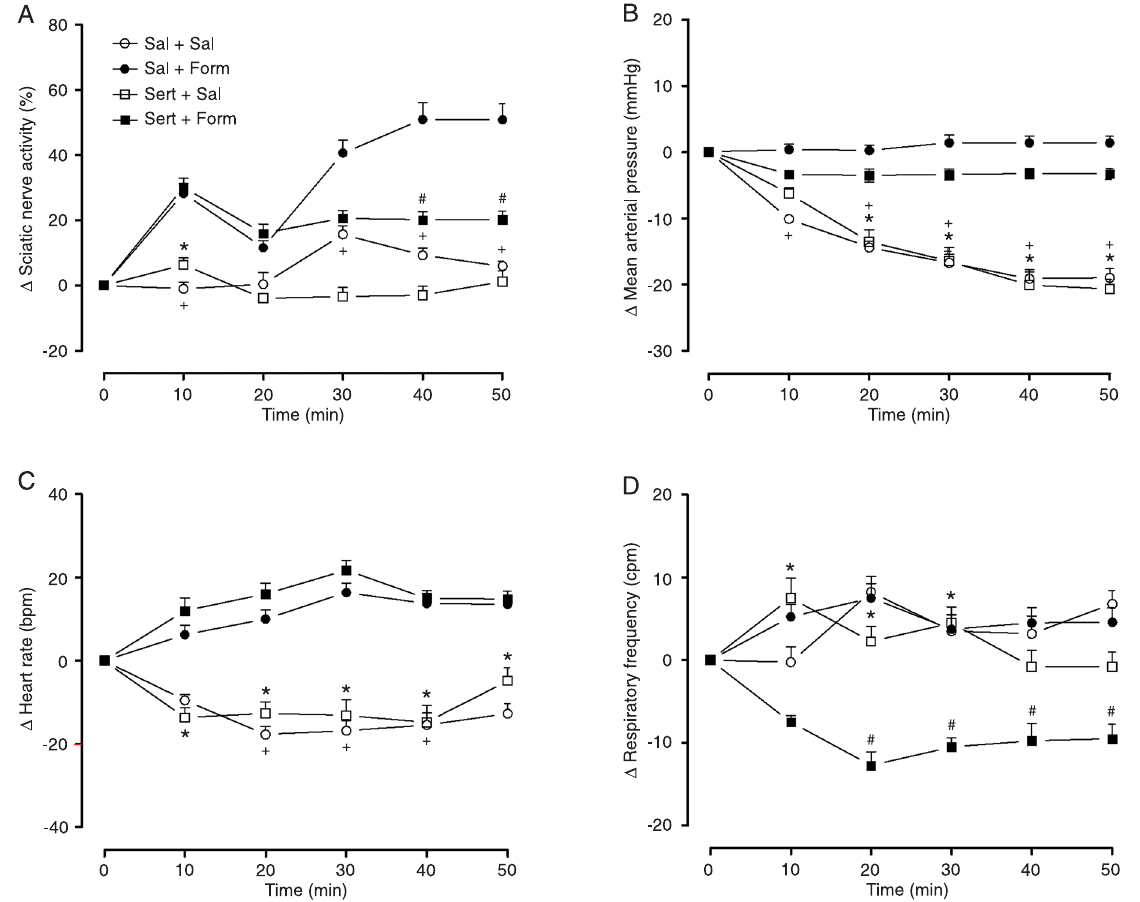
Figure 1. Effects of sertraline administration on A , sciatic nerve activity; B , mean arterial pressure; C , heart rate; D , respiratory fre- quency in an animal model of acute pain produced by the injection of 50 μL 5% formalin. Data are reported as means ± SEM for N = 8 rats per group. Sal = saline; Form = formalin; Ser = sertraline. *P < 0.05, Sert + Form vs Sert + Sal group; + P < 0.05, Sal + Form vs Sal + Sal; # P < 0.05, Sal + Form vs Sert + Form group (analysis of variance (ANOVA) followed by the post hoc Fisher